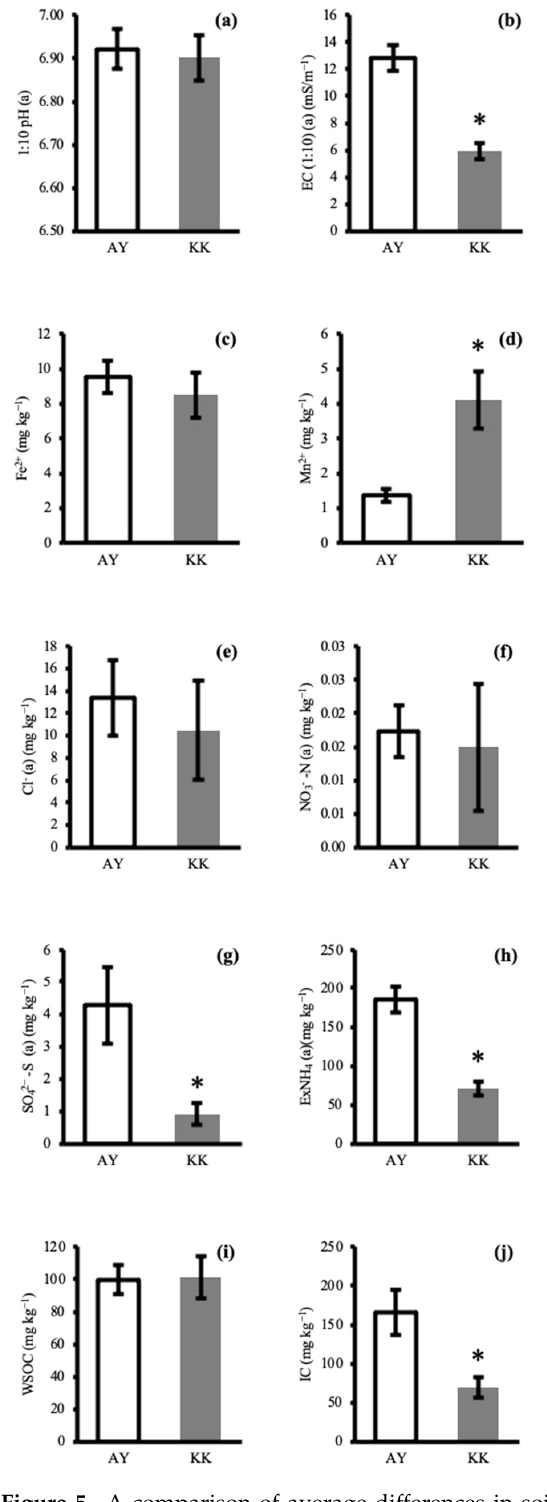
Figure 5. A comparison of average differences in soil properties after incubation in Ayutthaya and Khonkaen. 1:10 pH(a) ( a ); 1:10 EC(a) = 1:10 electronic conductivity ( b ); Fe 2+ = Ferrous ion ( c ); Mn 2+ = Manganese ion( d ); Cl − = Chloride ( e ); NO 3 − -N = Nitrate ( f ); SO 4 2 —S = Sulfate ( g ); ExNH 4 = Exchangeable ammonium ( h ); WSOC = Water soluble organic carbon ( i ); IC = Inorganic carbon ( j ). Asterisk (*) represents a significant difference at the p < 0.05 level between the 2 areas. Figures of PO 4 3 − -P and NO 2 − -N are not